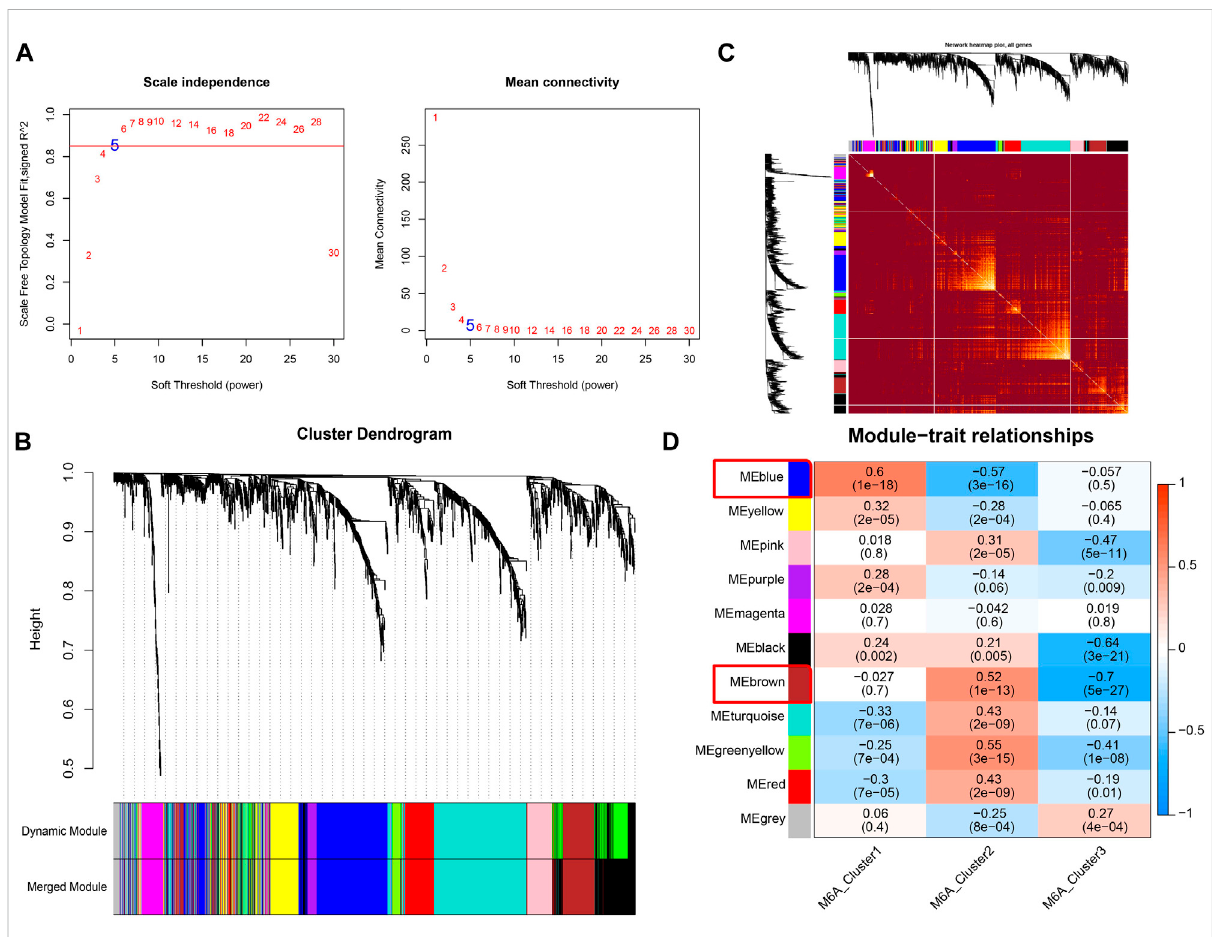
FIGURE 6 Co-expression identi fi es drug targets associated with m6A modi fi cation. (A) Left image: Adjacency matrix weight parameter power selection graph. The horizontal axis represents the weight parameter power, and the vertical axis represents thesquare of thecorrelation coef fi cient between log (k) and log [p(k)] in the corresponding network. The higher the squared value of the correlation coef fi cient, the closer the network is to the distributionwithoutnetworkscale.Theredlinerepresentsthestandardlinewherethesquaredvalueofthecorrelationcoef fi cientreaches0.85. Right image: Schematic diagram ofthe average connection degree ofgenes under different adjacency matrix weight parameters, power parameter. The red line represents the value of the average connection degree of network nodes under the value of the power parameter of the adjacency matrix weight parameter in the left image. (B) Module division tree diagram. Each color represents a different module. (C) Heatmap of the Topological Overlap Metric (TOM) matrix. Light yellow represents lower TOM, and darker red represents higher TOM. (D) Heatmap of the correlations of individual modules with m6A-modi fi ed